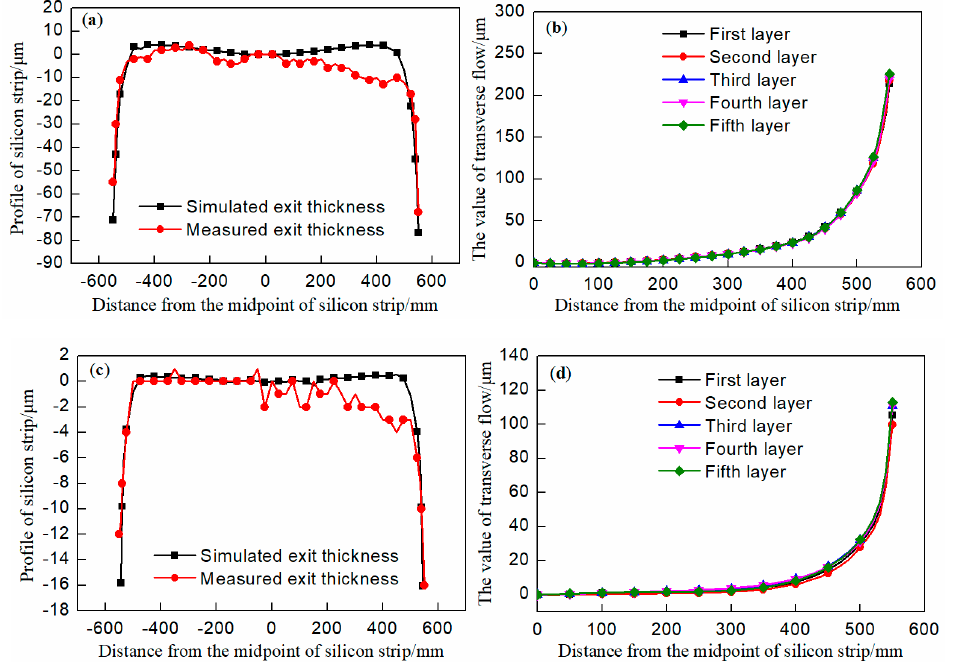
Figure 4. Verification of the finite element models: ( a ) The exit profile of the first pass; and ( b ) the metal transverse flow of the first pass; ( c ) the exit profile of the fifth pass; and ( d ) the metal transverse flow of the fifth pass.